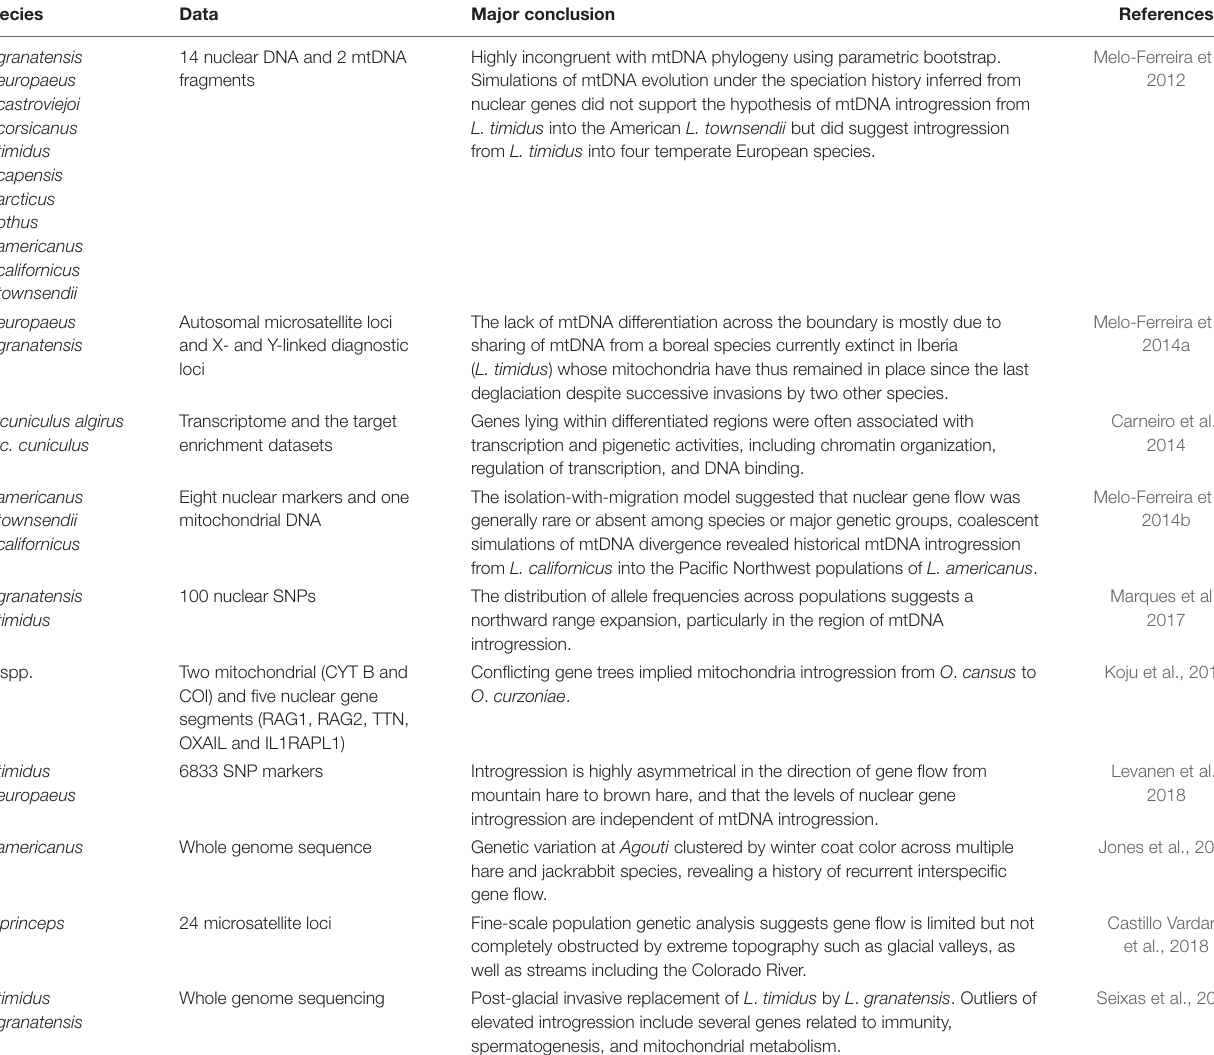
TABLE 1 | Research activities related to hybridization of